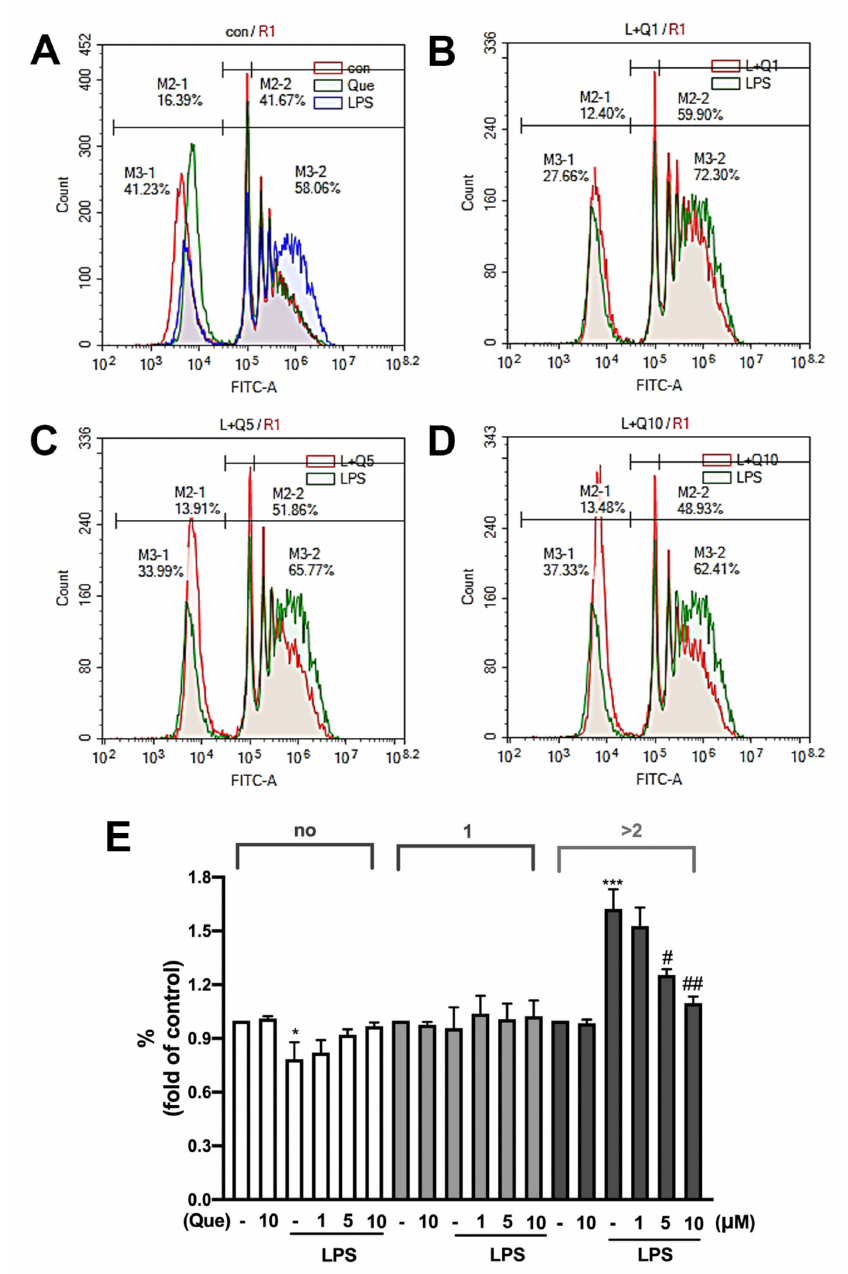
Figure 7. Effects of quercetin on the phagocytic ability of microglial cells. ( A ) IMG cells were stimulated either with quercetin (10 µ M) or LPS (10 ng/mL) alone for 24 h. In figure B to D, following LPS (10 ng/mL) stimulation, cells were also co-treated with quercetin (1 µ M in ( B ); 5 µ M in ( C ); 10 µ M in ( D )) for 24 h. By monitoring the degree of fluorescence intensity by flow cytometry, populations of microglia that engulfed 0, 1, 2, or more beads can be differentiated. The quantitative results were shown in ( E ). Each bar represents the mean ± SEM of n = 4. Note: *** p < 0.005, * p < 0.05 compared with the control group. ## p < 0.01, # p < 0.05 compared with the LPS alone